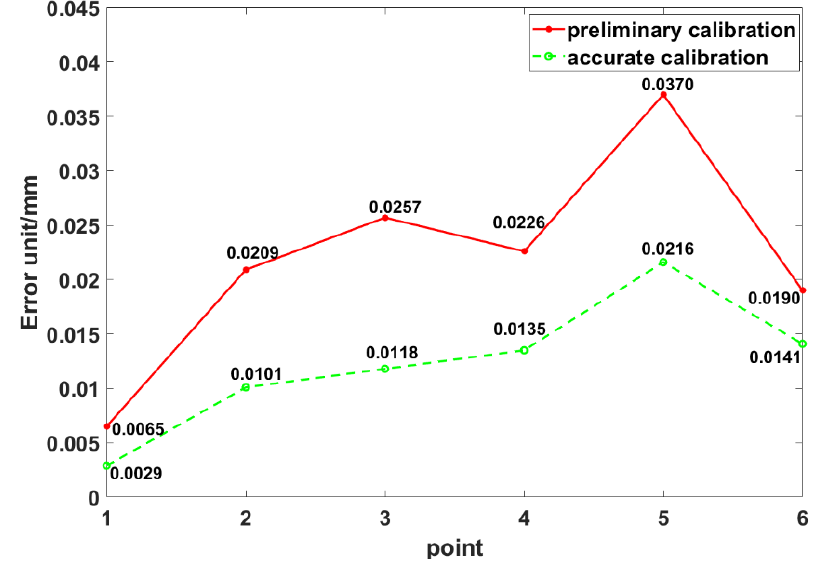
Figure 9. Errors of the coordinate transformation after preliminary and accurate calibration.